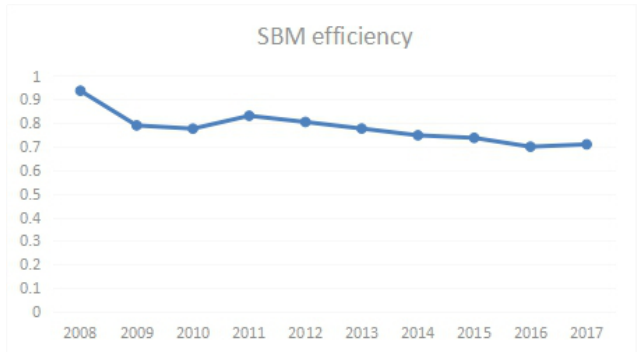
Fig. 1 Trend of overall efficiency value of manufacturing industry in Chongqing from 2008 to